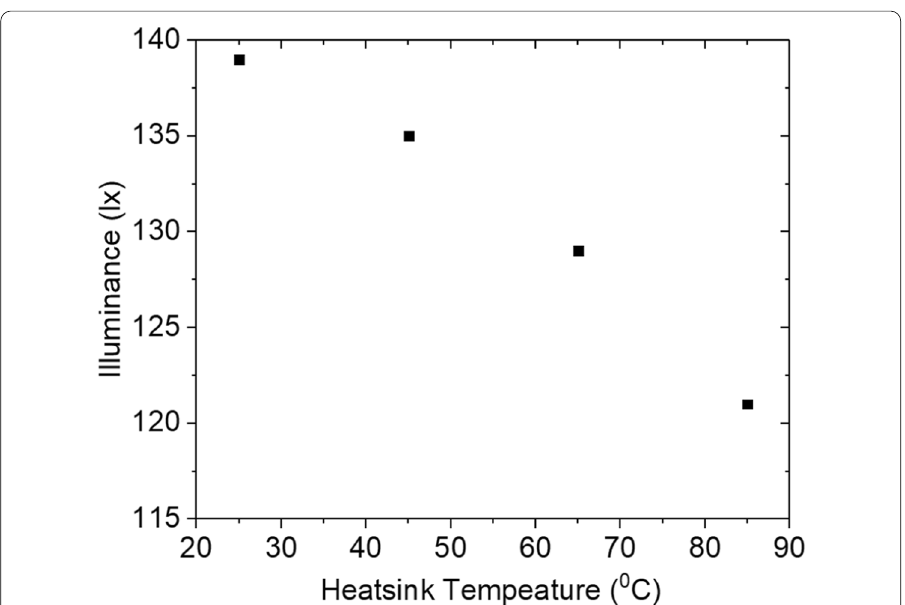
Fig. 2 Illuminance versus heatsink temperature of LED device under “constant voltage amplitude and constant bias voltage”